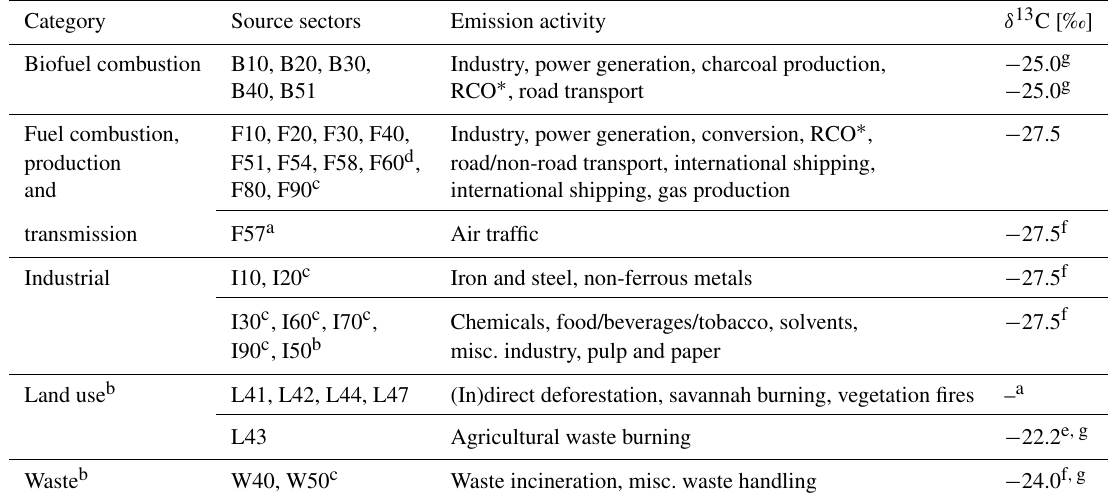
Table 1. Description of EDGAR FT32 emission source sectors and associated isotopic signatures. Category Source sectors